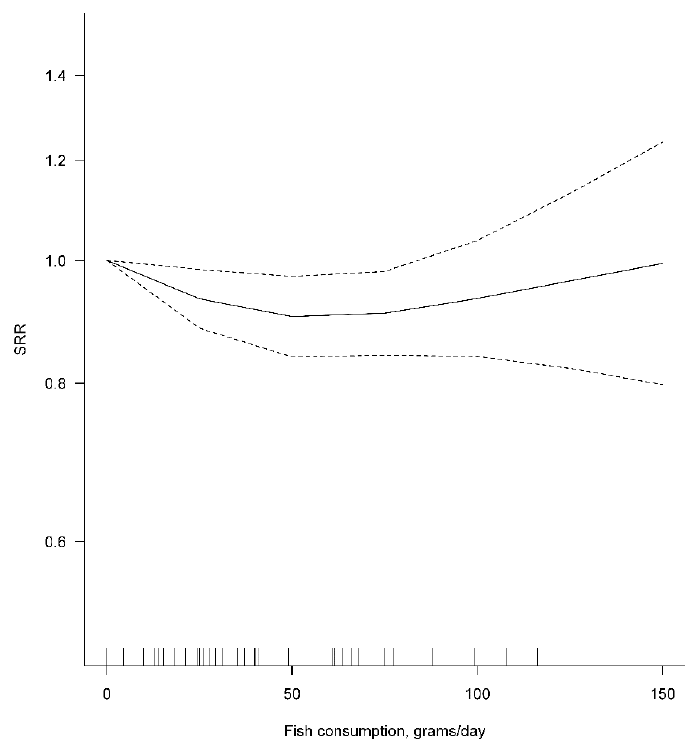
Figure 3. Non-linear dose–response meta-analysis for the association between fish consumption (g/day) and colorectal cancer risk. SRR: summary relative risk.